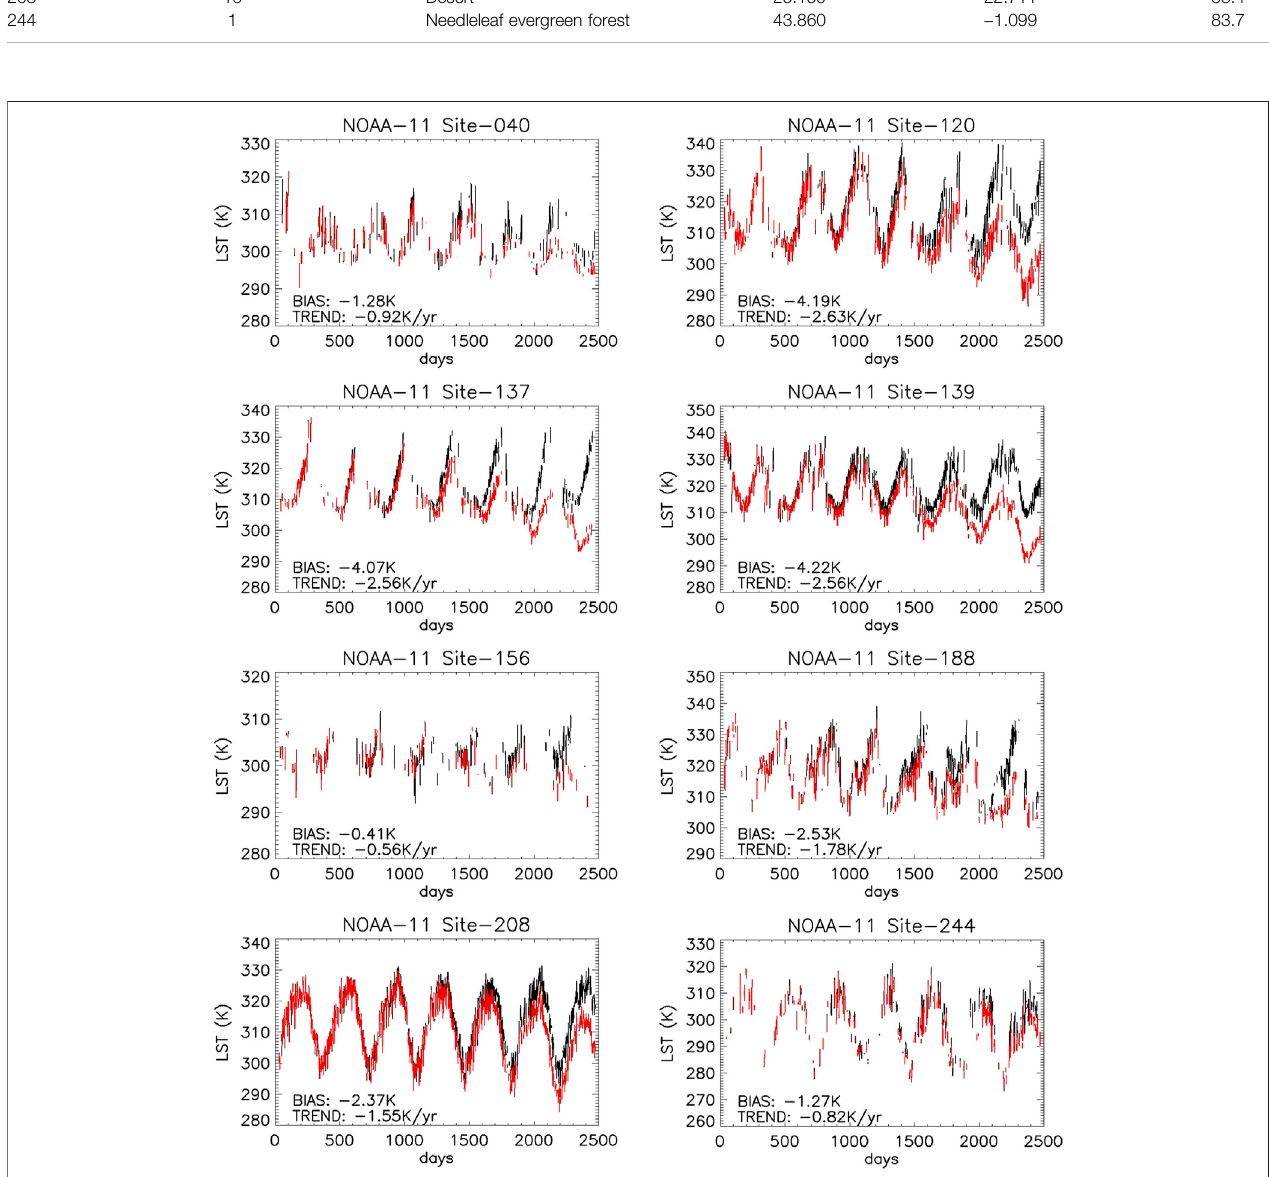
FIGURE4| SimulatedtimeseriesforNOAA-11platformforeightselectedsites:reference(black)anddrifted(red)timeseriesalongwiththeresultingbiasandtrend difference statistics.